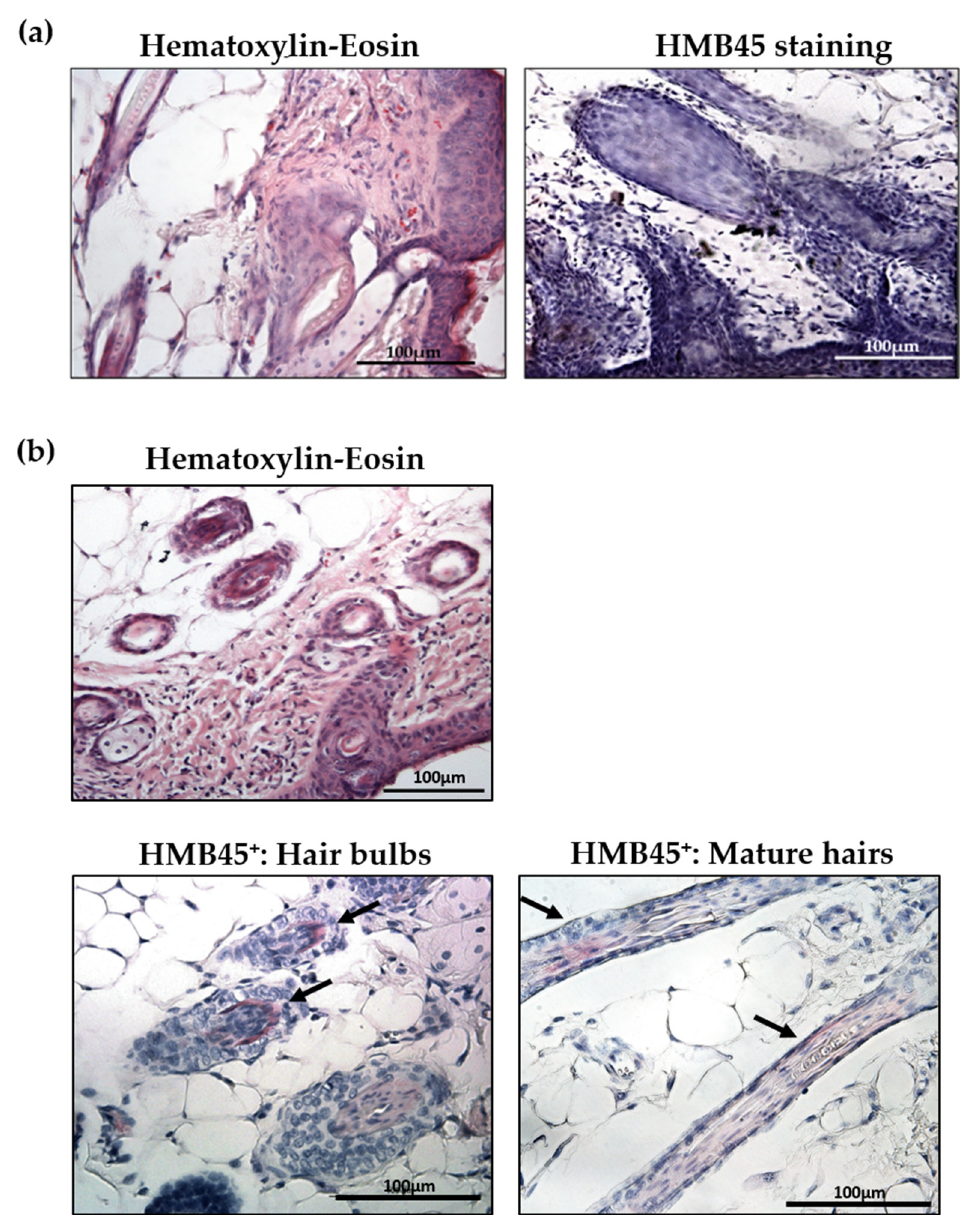
Figure 2. ( a ) Representative hematoxylin–eosin ( left ) and HMB45 immunohistochemistry ( right ) of skin sections from control mice. ( b ) Representative hematoxylin–eosin (upper panel) and HMB45 immunohistochemistry (lower panels) of skin section of mice injected with TSC2 -/meth cells. HMB45- positive cells were stained in red (highlighted by arrows). Nuclei were stained with hematoxylin. Scale bar: 100 µm.